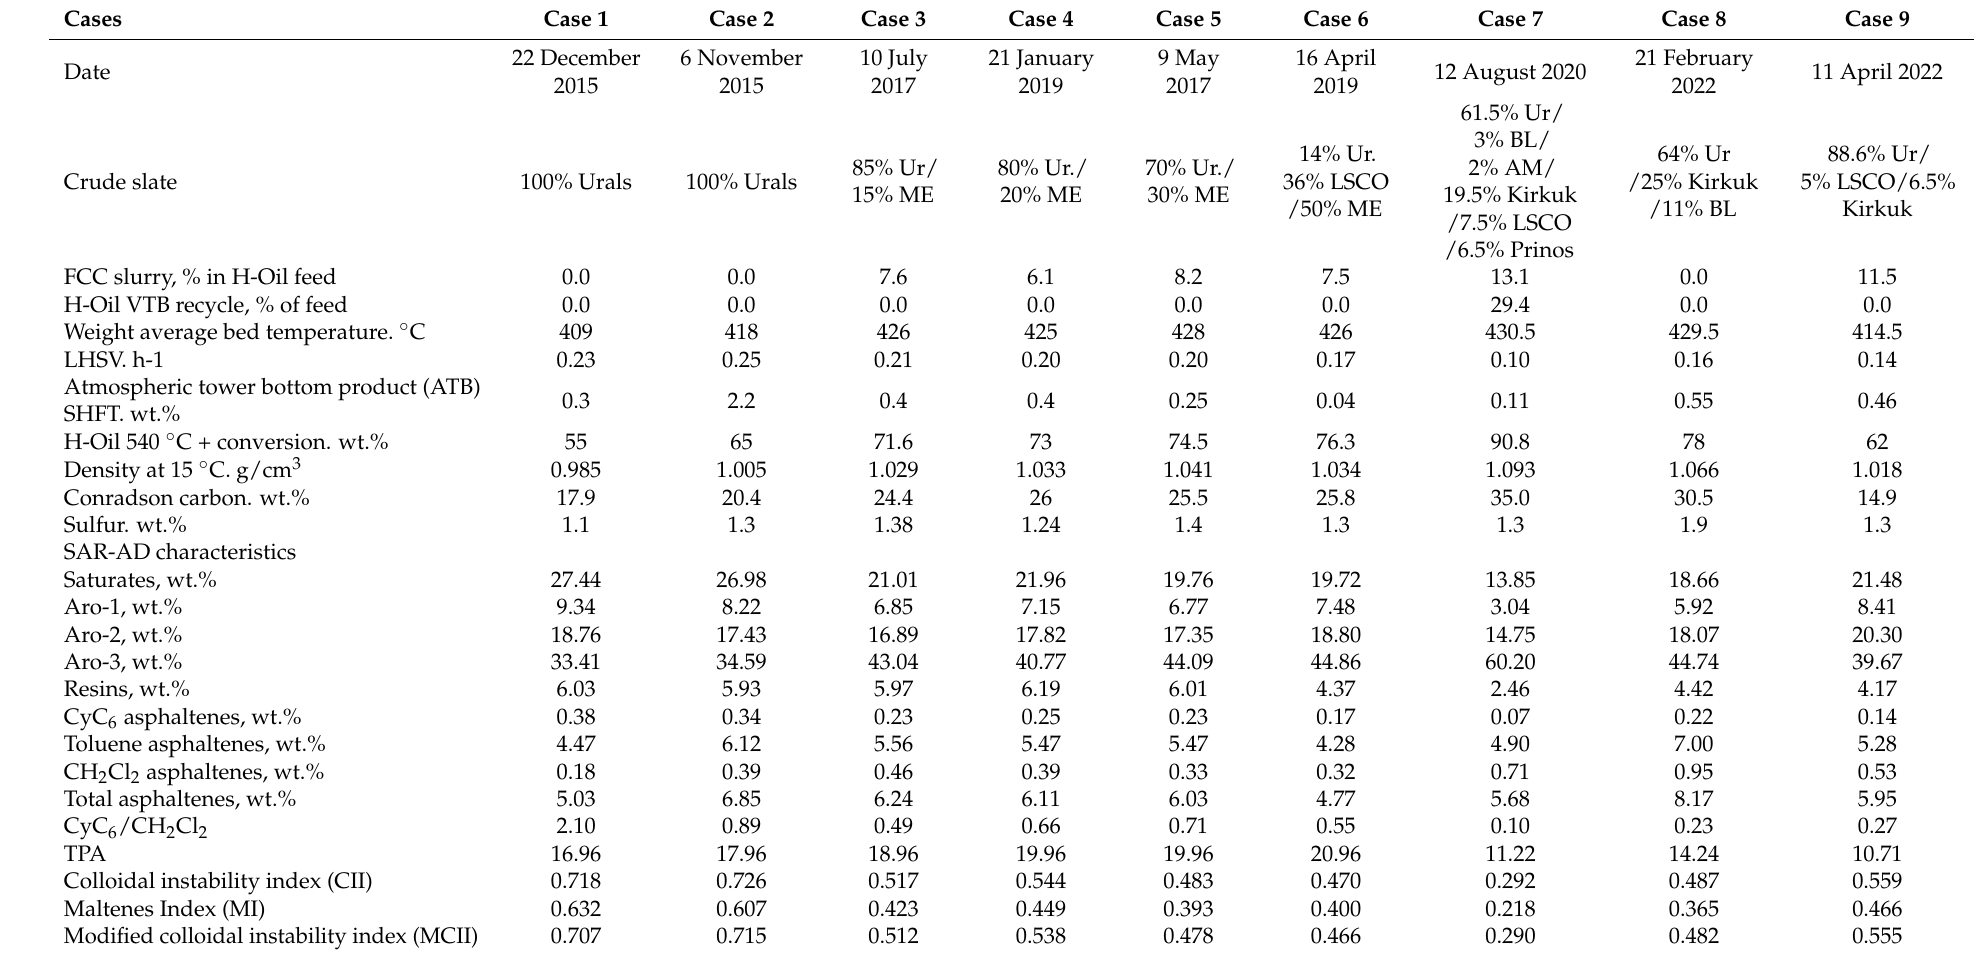
Table 2. Bulk properties and SAR-AD characteristics of hydrocracked vacuum residues (VTB) obtained at the commercial LNB H-Oil